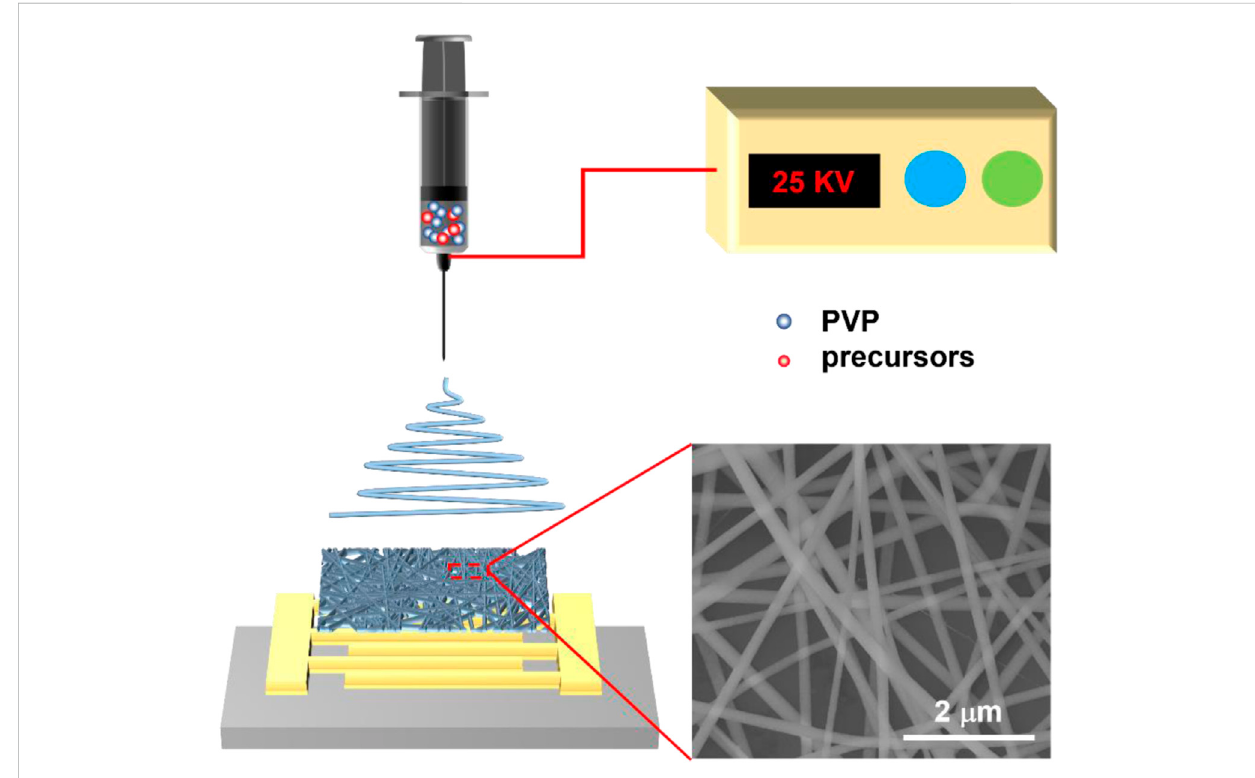
FIGURE 1 Schematic diagram of the electrospinning process and electron microscope image of as-spun nano fi bers.